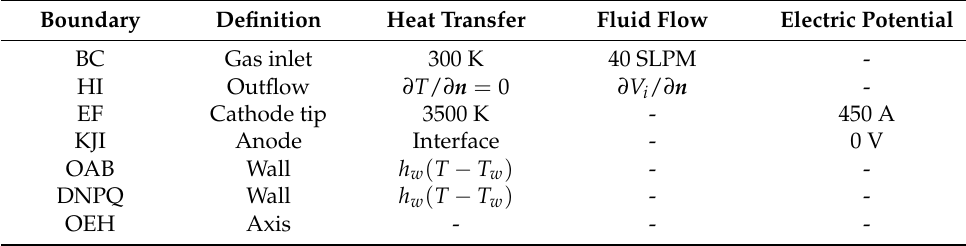
Table 4. Main boundary conditions for simulation inside SinplexPro™ plasma spray